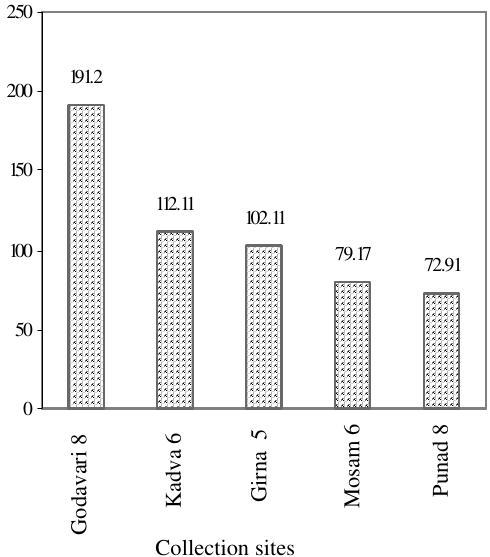
Figure 1. Comparative graph of higher amount of phosphate and the collection sites of higher polluted areas of various rivers of Nasik